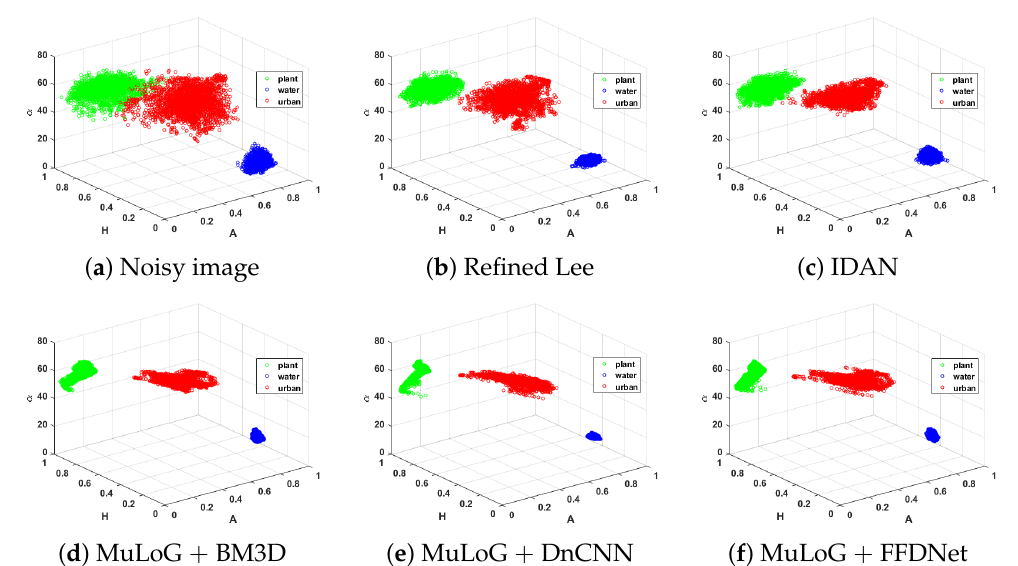
Figure 18. The scatter grams of the Cloude polarimetric decomposition parameters for different areas for GF-3 PolSAR image with L = 1: ( a – f ) Noisy image, Refined Lee, IDAN, MuLoG + BM3D, MuLoG + DnCNN, and MuLoG + FFDNet,